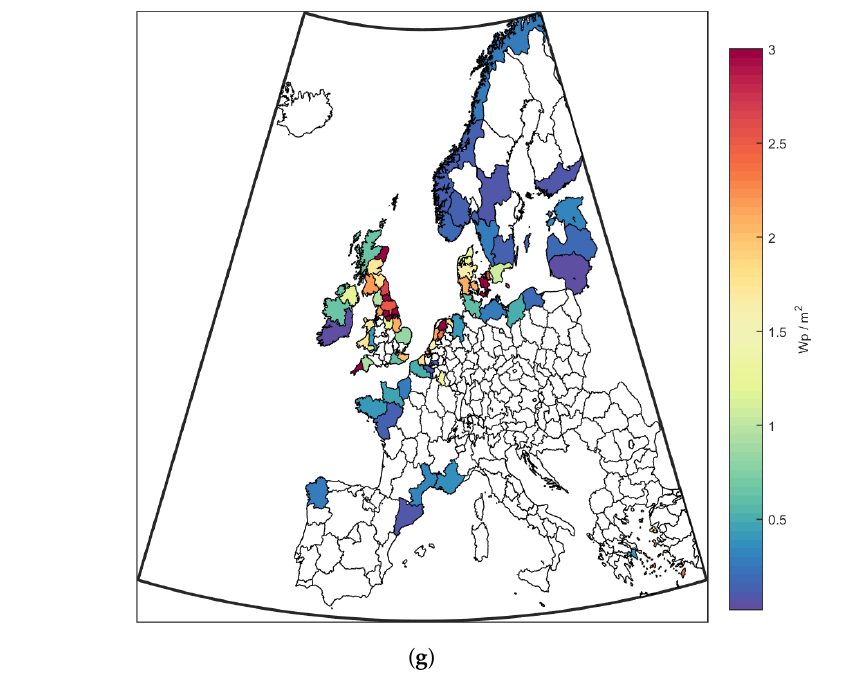
Figure 1. Model results for the base scenario including ( a ) the capacity of electricity generation investments, ( b ) the capacity of new transmission (GW p ) and storage (GWh) investments, ( c ) the electricity generated by generation type and year plus yearly electricity transmitted internationally and yearly energy transferred to storage, ( d ) the upper limit allowed by the model and the actual CO 2 emissions over time, ( e ) the price of electricity in each of the countries and the marginal cost of CO 2 abatement over time, ( f ) the installed capacity of solar PV power plants, and ( g ) the installed capacity density of wind power. Note that the order of the legends for line and area plots corresponds to the order of the respective values in 2010 from top to bottom. Note also that the color of the regions/quadrants on map plots indicates the installed capacity density in the given region/quadrant where white signifies zero